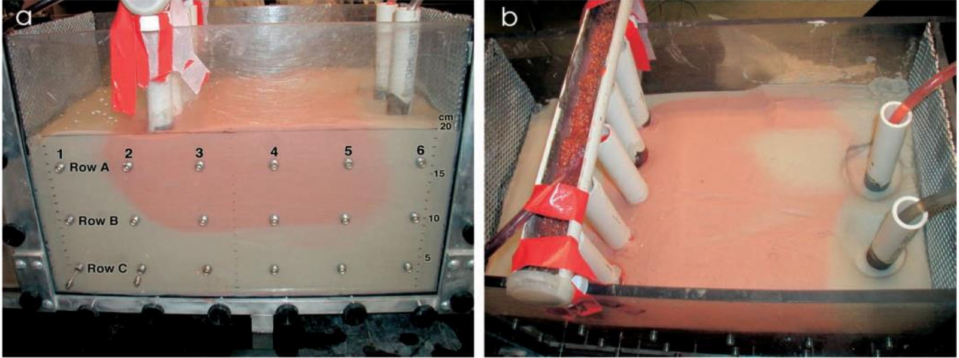
Figure 5. Setup of the box model experiment (grout flow is from left to right): side ( a ) and plan ( b ) view after 3 h CS progression ([51] with